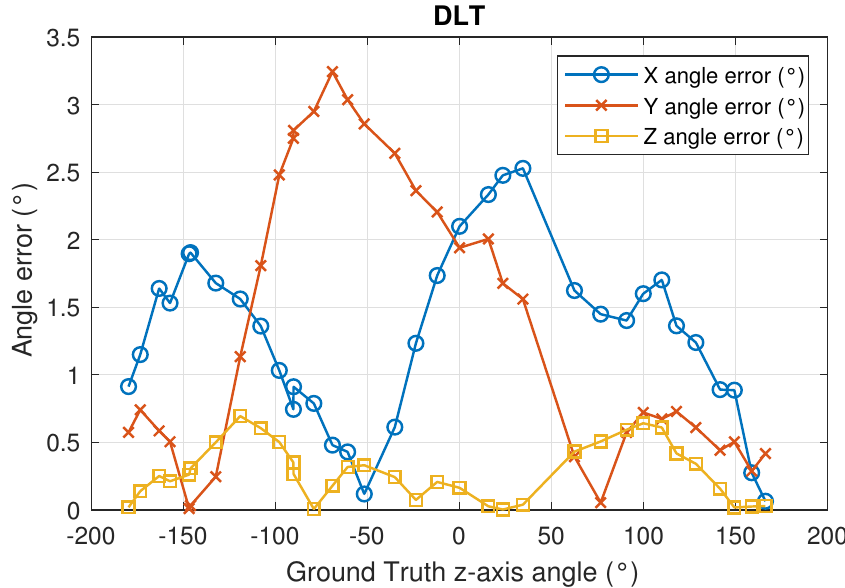
Figure 16. Angle error in the 3 axes using DLT in function of the true value rotation angle (z angle).